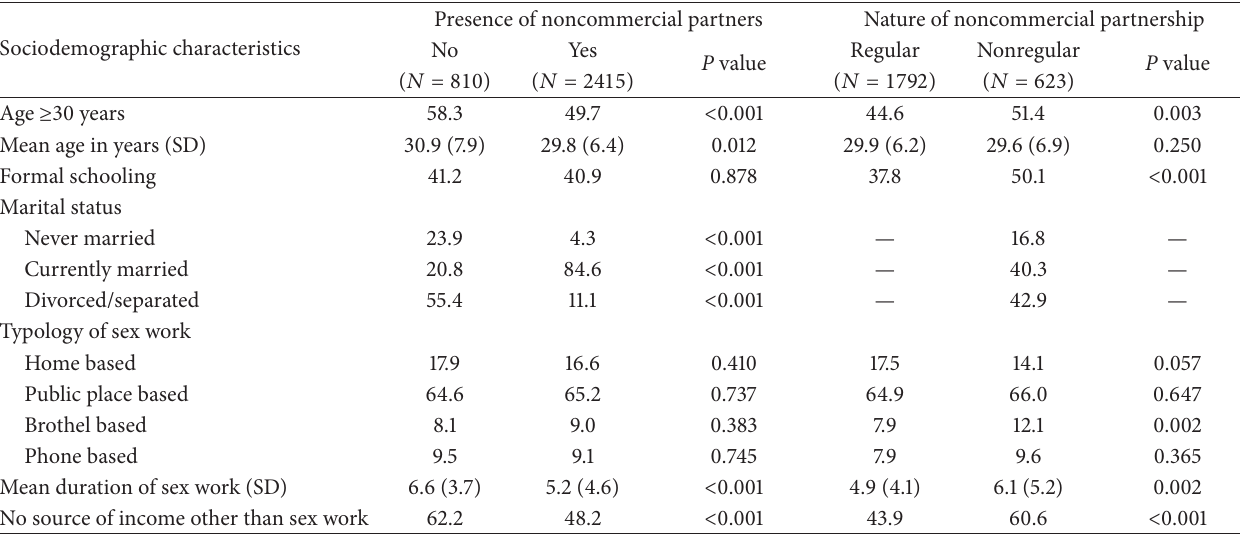
Table 1: Sociodemographic characteristics of female sex workers by presence and nature of noncommercial partnerships, Andhra Pradesh, 2009 ( 𝑁 = 3225